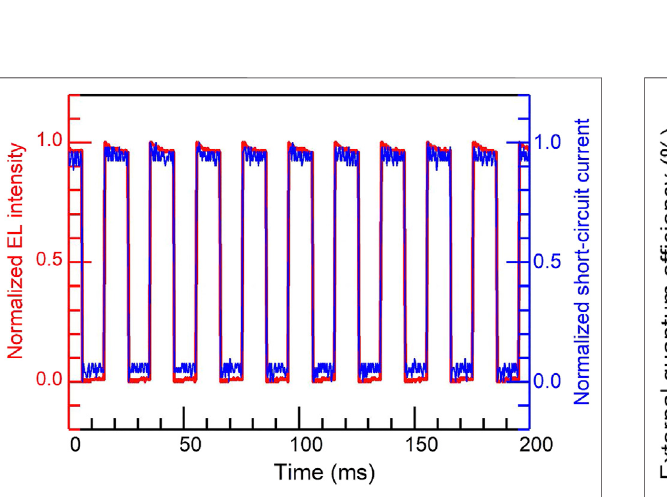
FIGURE 9 | Responses of normalized EL intensities and short-circuit current densities.